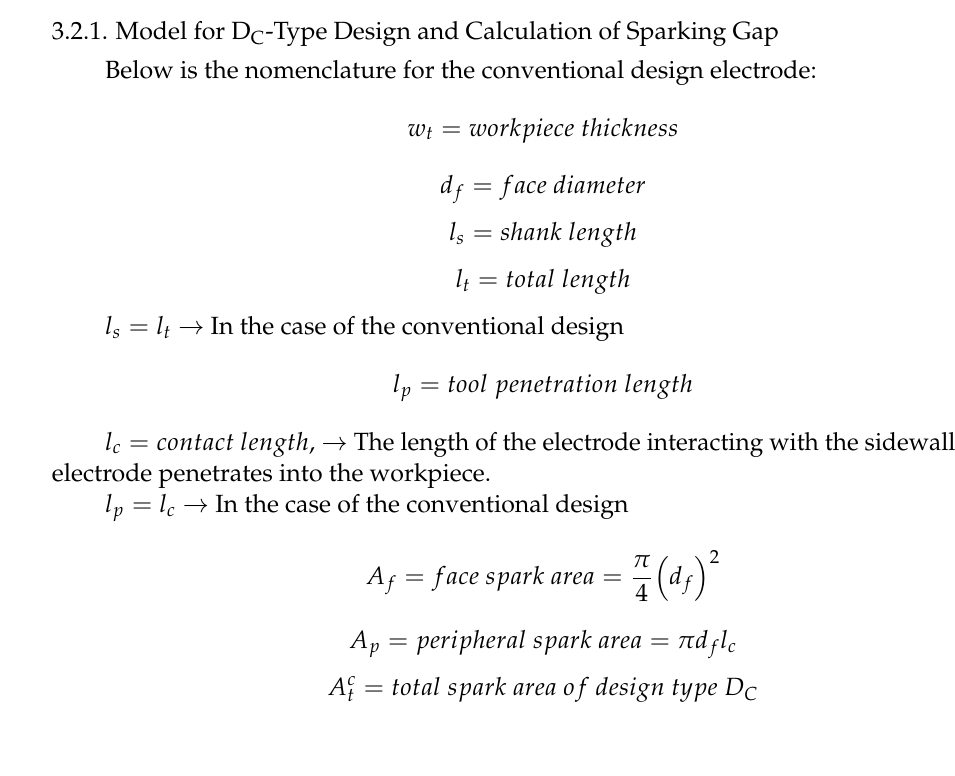
Figure 6. Drawings of different electrode designs used to develop spark area models: ( a ) design type D C , ( b ) design type D R , and ( c ) design type D RL